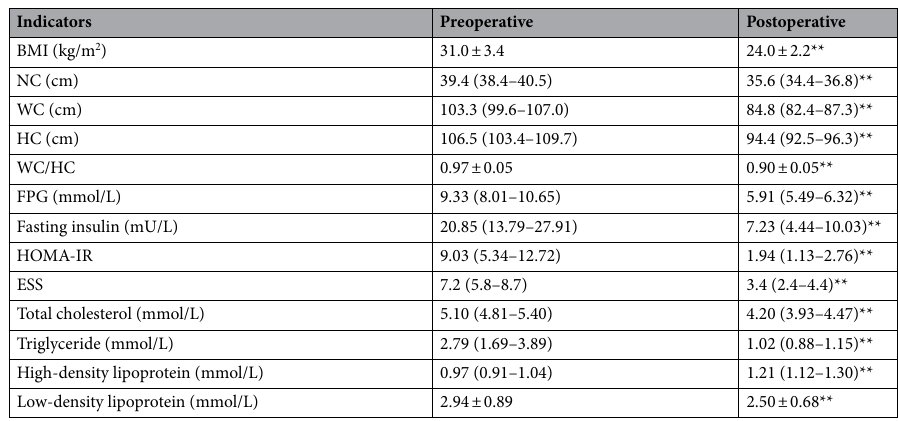
Table 1. Clinical characteristics of the patients at baseline and one year after RYGB. Data are expressed as the mean ± SD or mean with 95% confidence interval. RYGB Roux-en-Y gastric bypass, BMI body mass index,